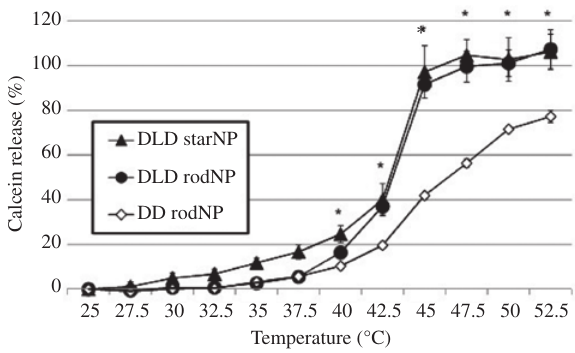
Figure 6: Curves indicating calcein release profiles (DLD, 1,2-dipalmitoyl-sn-glycero-3-phosphocholine, 1-stearoyl-2-hy- droxy-snglycero-3-phosphocholine,1,2-distearoyl-sn-glycero- 3-phosphoethanolamine-N-[methoxy(polyethylene glycol) and DD, 1,2-distearoylsn-glycero-3-phosphocholine, 1,2-dipalmitoyl-sn-glyc- ero-3-phosphocholine). Reprinted with permission from Ref.